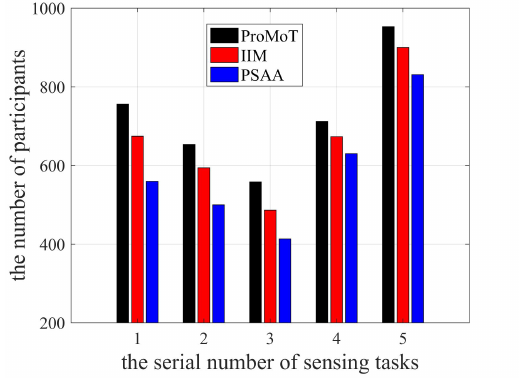
Figure 7. The number of